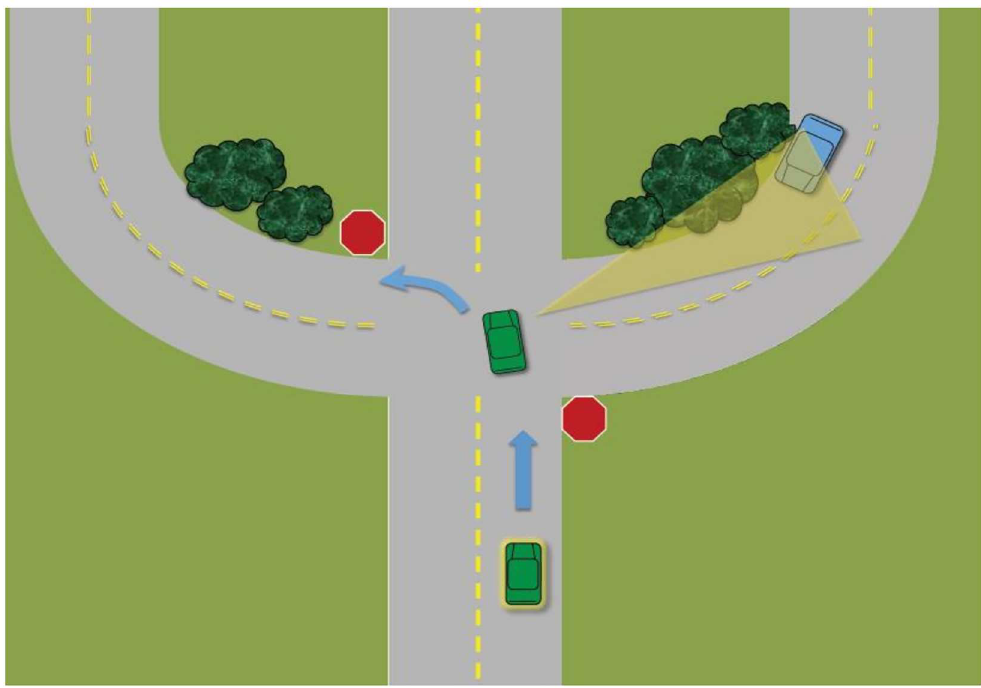
Fig 1. A schematic example of a sign-controlled 4-way intersection with a target zone (area shaded by yellow cone) that contains a latent hazard. (Prior to the stop sign, drivers should make primary glances side to side. After entering the intersection and before executing a turn, drivers shouldtake secondaryglances to the areas defined as the target zones. In this example, drivers should look toward the target zone before making a left turn. The blue car—a latent hazard—was not actually present in the